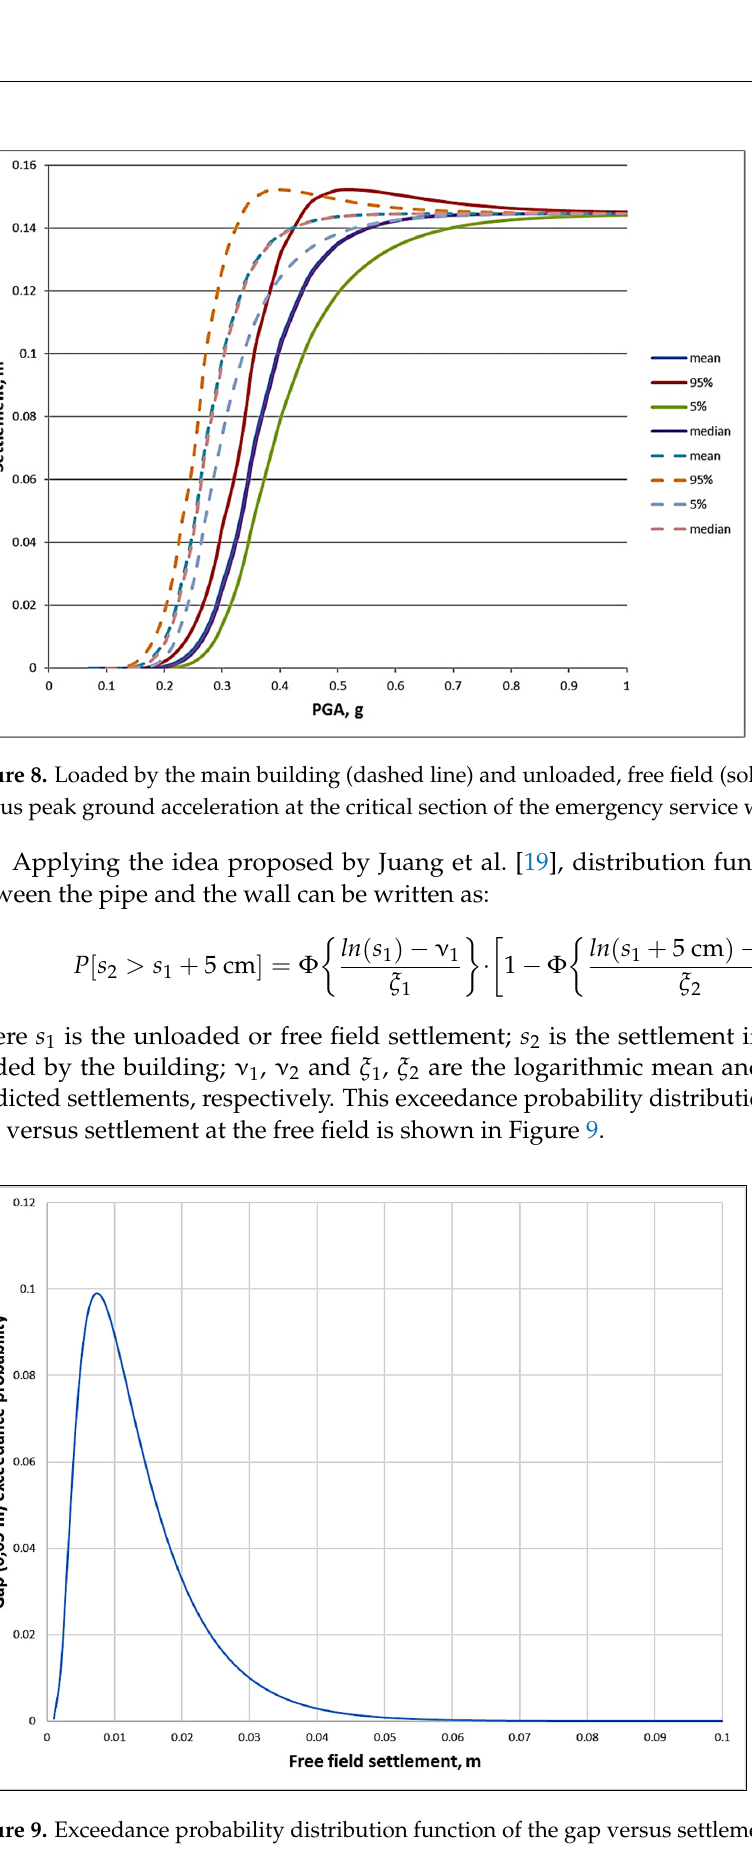
Figure 9. Exceedance probability distribution function of the gap versus settlement at the free field.